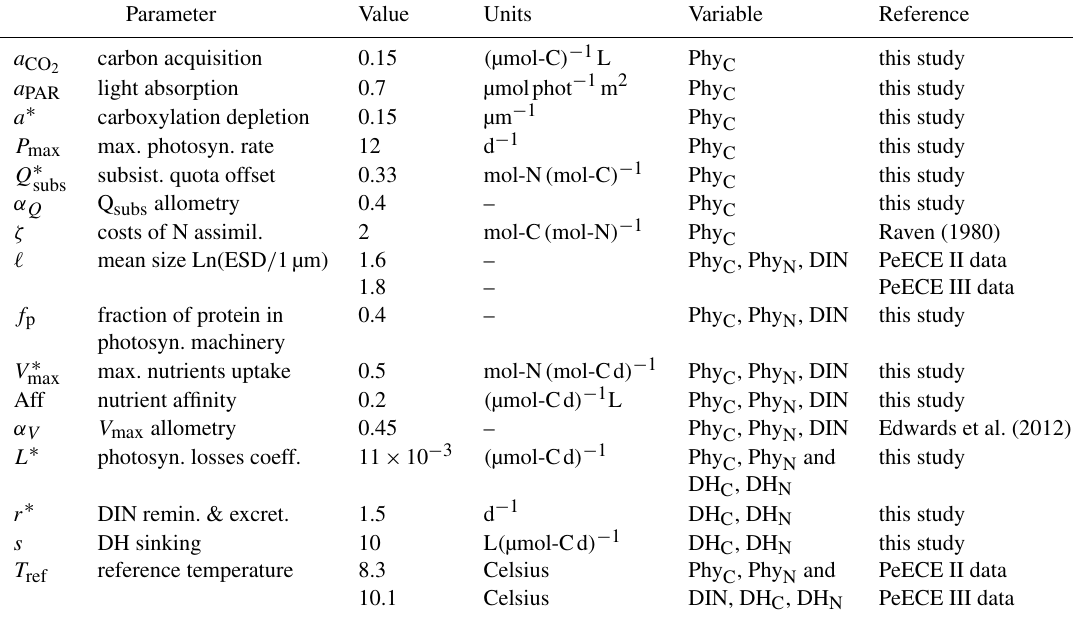
Table 2. Parameter values used for the reference run, (cid:104) φ i (cid:105) . All values are common to both PeECE II and III experiments, only the mean temperature (determined by environmental forcing) and the averaged cell size in the community are different since different species compo- sition succeeded in the experiments ( Emiliania huxleyi was the major contributor to POC in PeECE II (Engel et al., 2008) but also diatoms significantly bloomed during PeECE III (Schulz et al.,